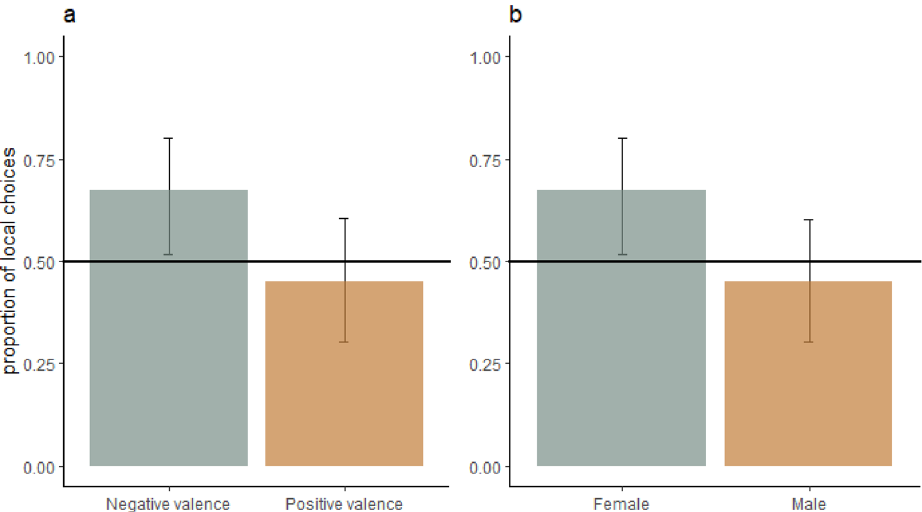
Figure 6. The effect of a. valence and b. sex on the proportion of local choices (predicted means ± CI) in the conflict test following the social emotional treatments (Table 2). The line indicates 0.5 proportion of local